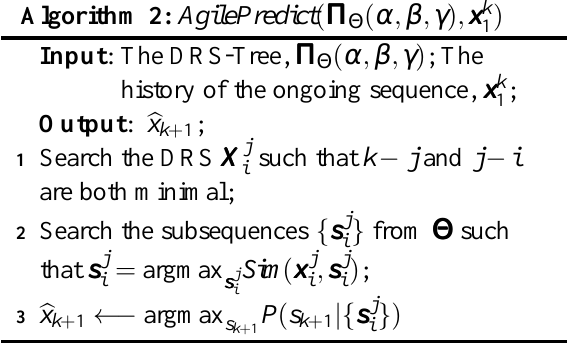
Algorithm 2: AgilePredict ( PPP Q ( a , b , g ) , xxx k